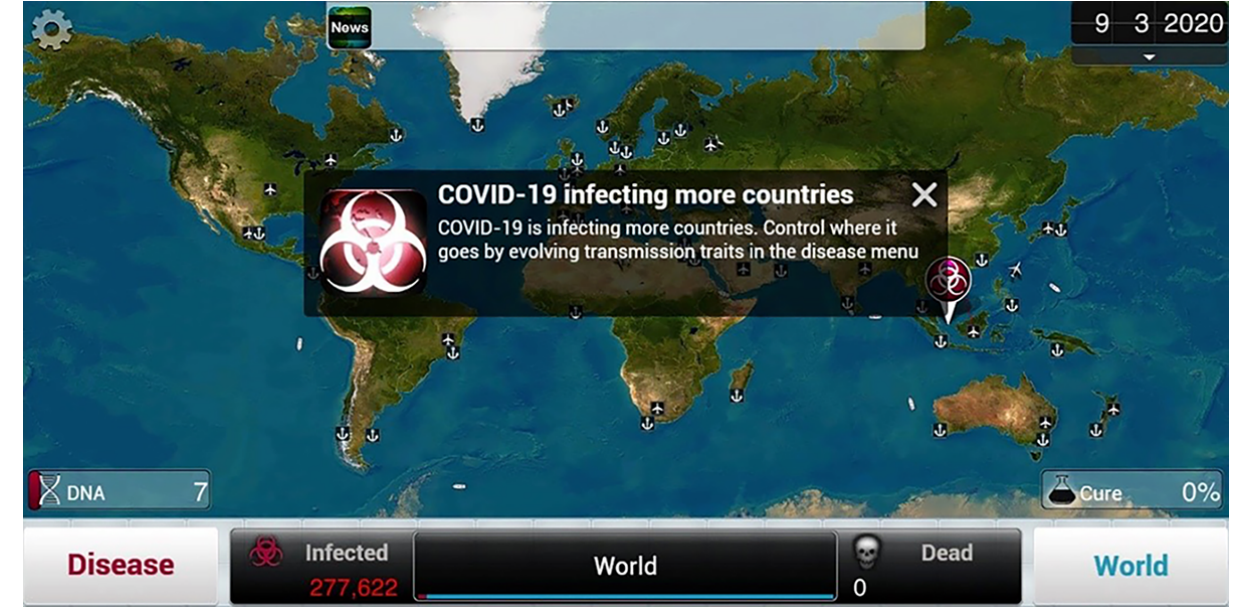
Figure 2. Screenshot of Plague Inc.